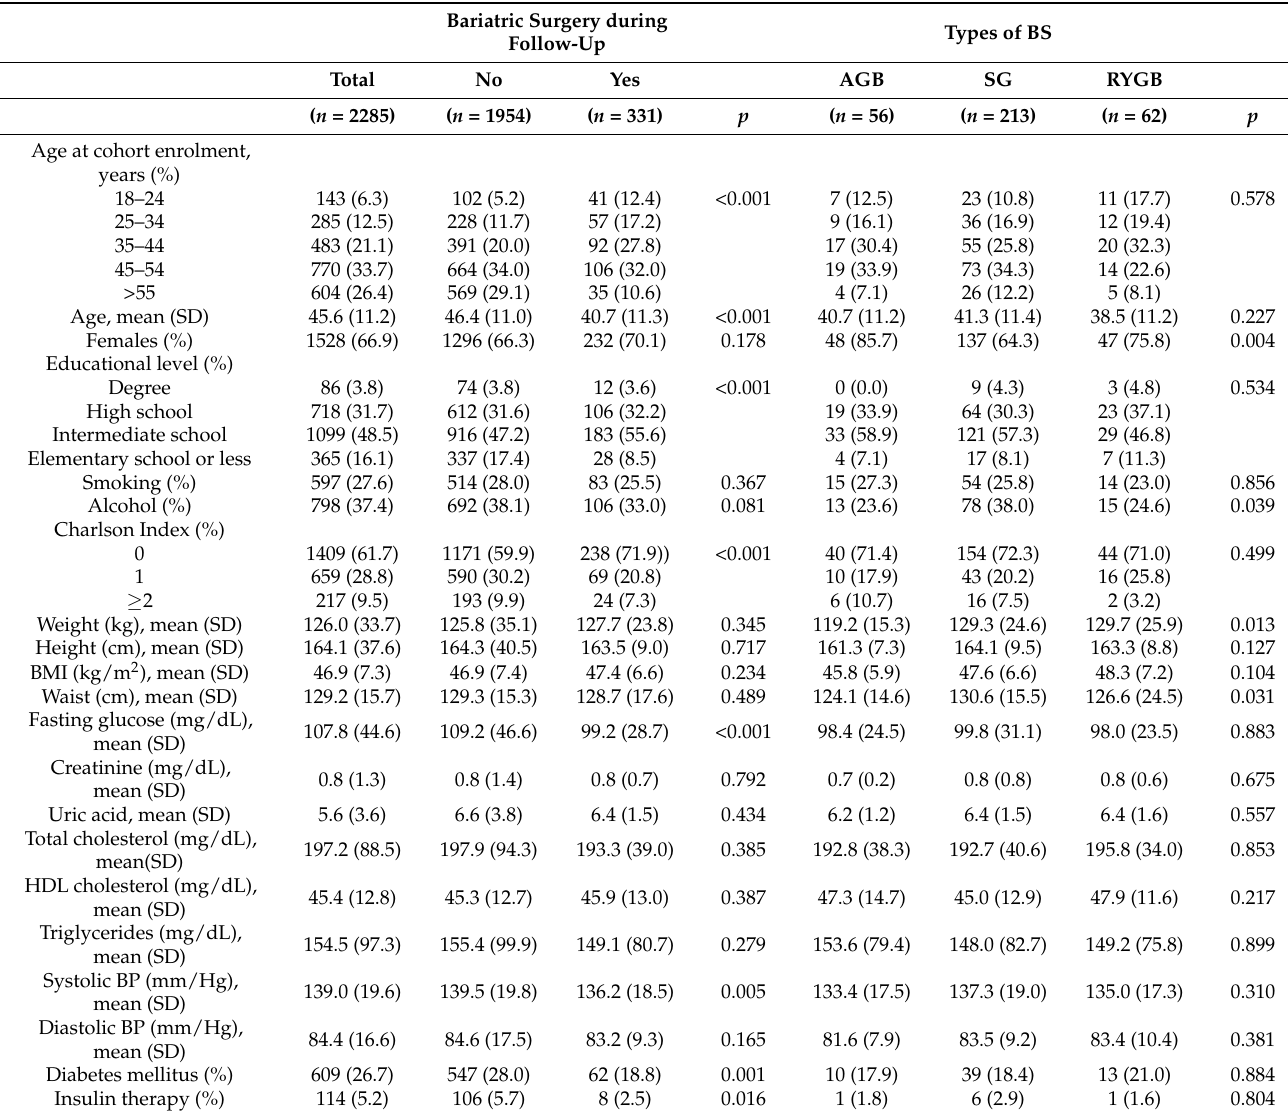
Table 1. Socio-demographic and clinical characteristics of the study cohort at baseline and of patients undergoing bariatric surgery (BS) intervention during follow-up, by type of